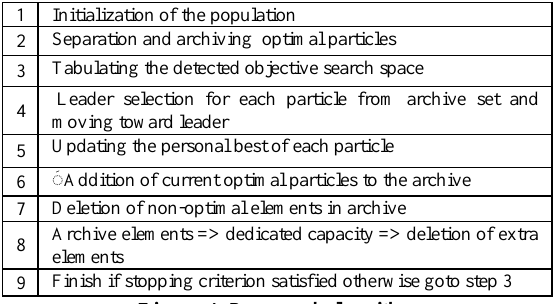
Figure 4. Proposed algorithm.